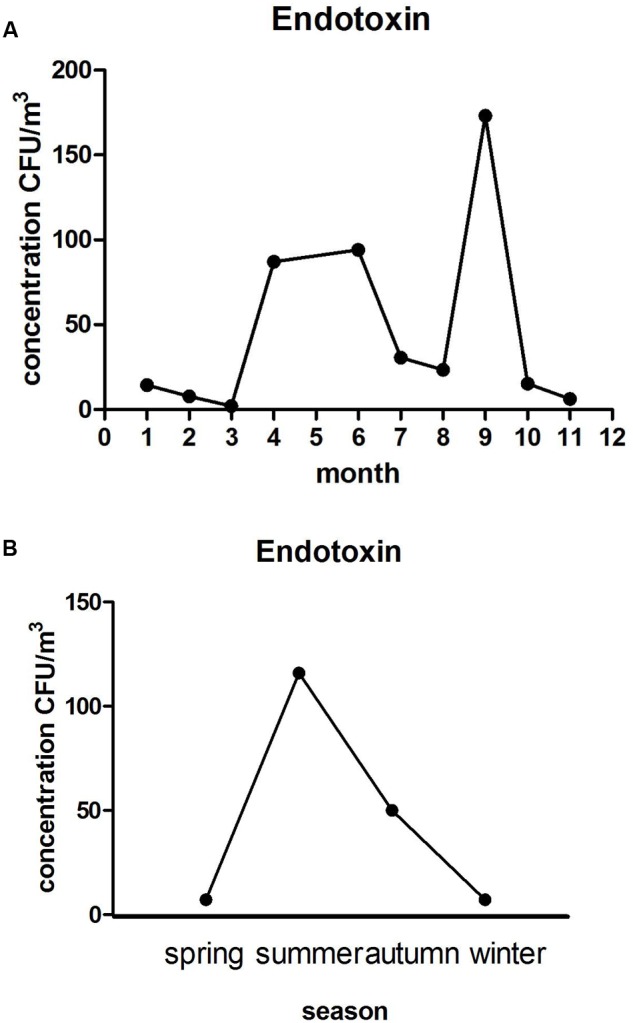
The monthly (A) and seasonal (B) average concentrations trend of endotoxin.